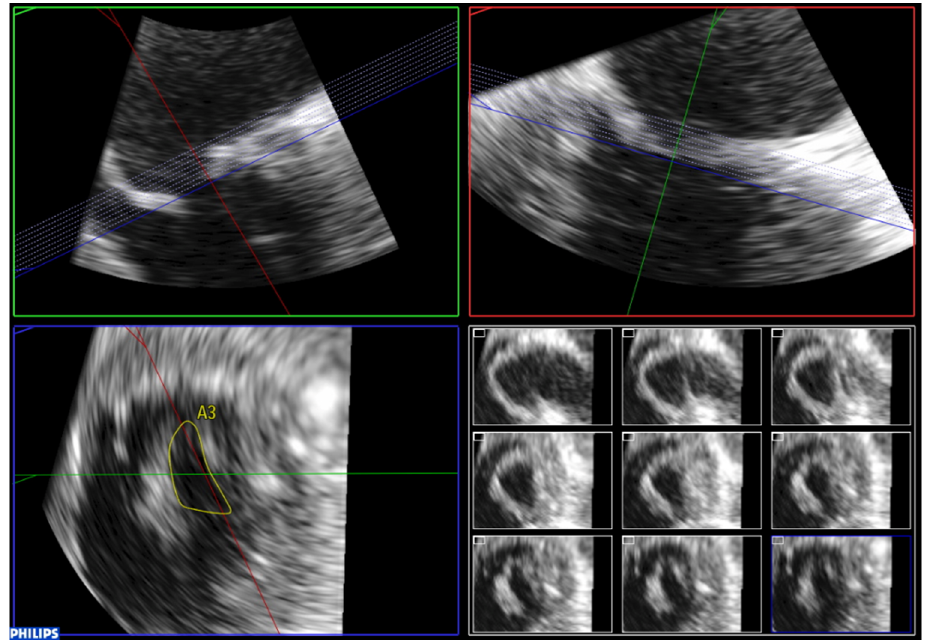
Figure 9. Analysis of zoom 3D dataset focused on the mitral valve obtained from the mid-esophageal four chamber view. Multiple short-axis slices are reconstructed to help identify the narrowest mitral valve